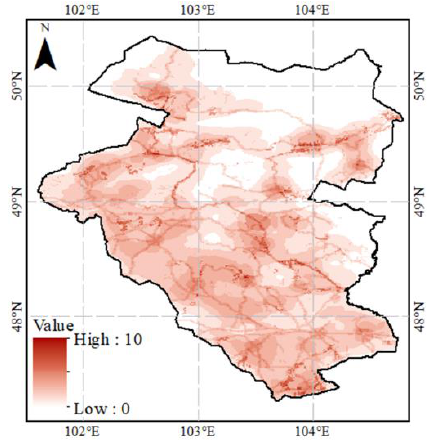
Figure 9. Spatial distribution of Human activity impact.